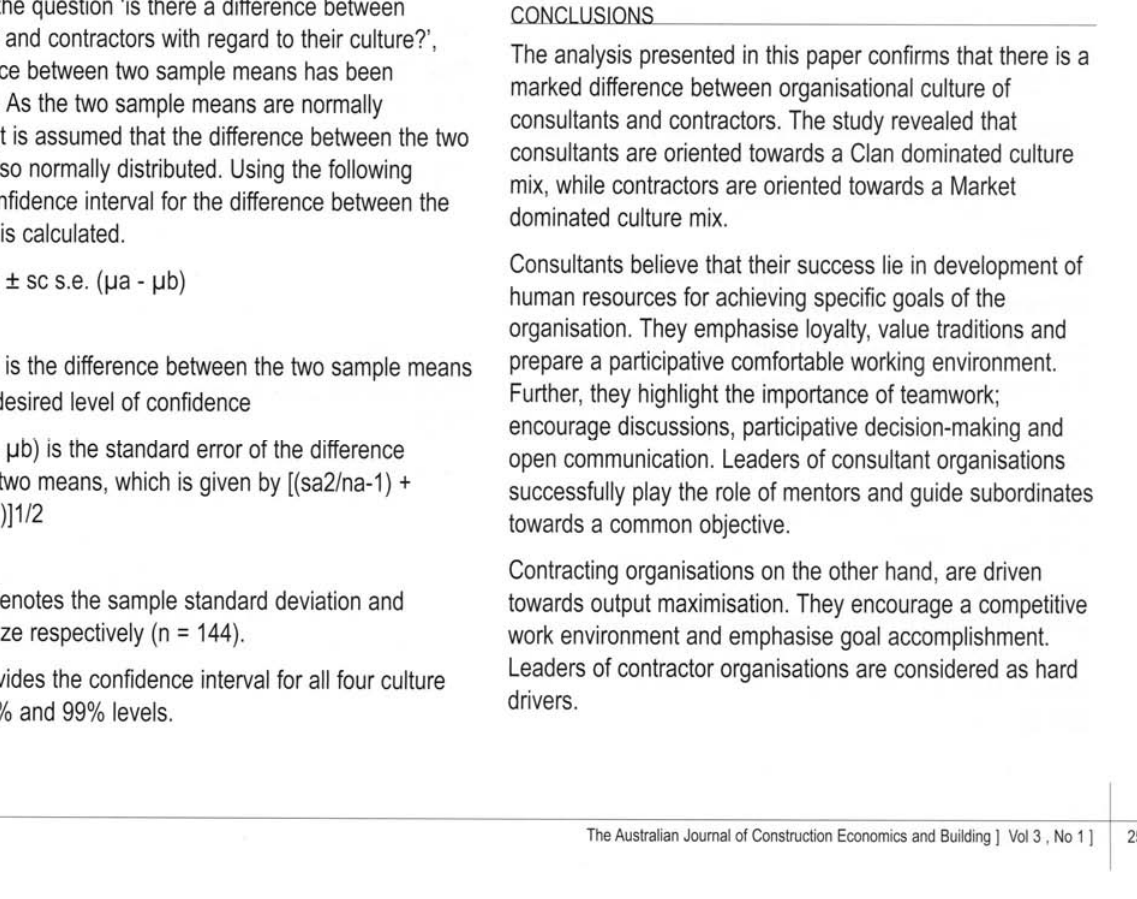
Table 4: Main distinguishing characteristics of consultants and